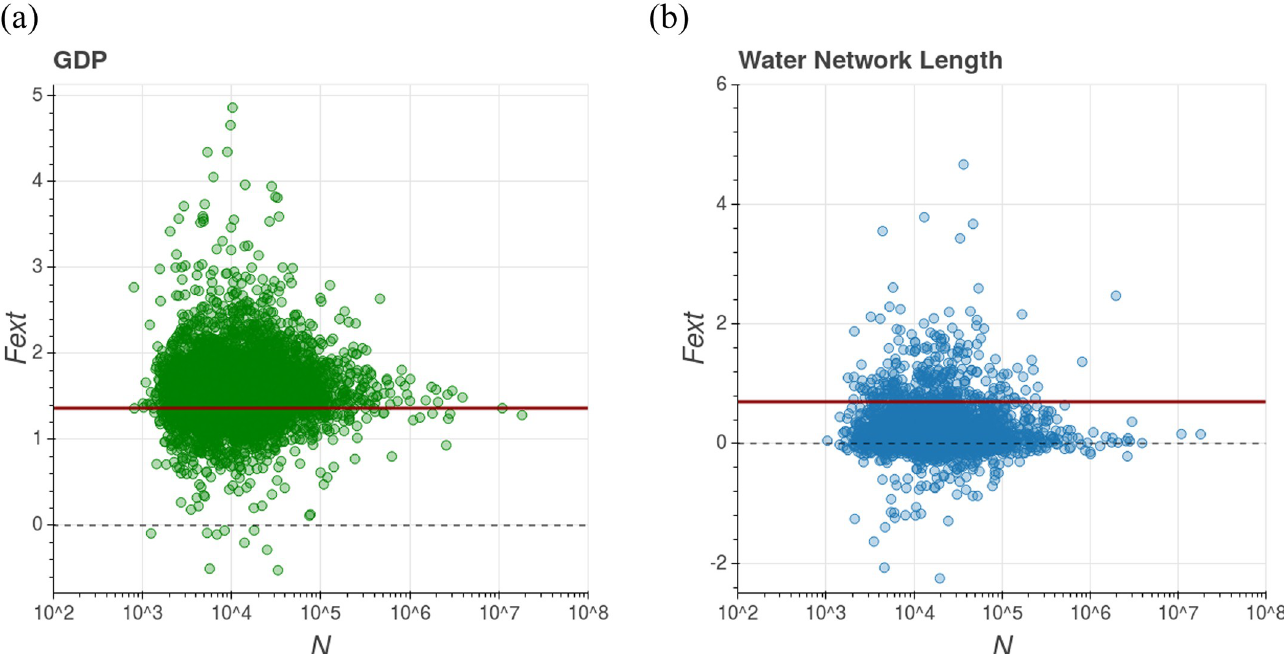
Fig 8. Magnitude of the external vector as a function of city population size. On the left, we have data referring to GDP and on the right to water network length. The dots represent F i computed from the expression (11) while the red line represents the average magnitude of this vector over the system, computed by ext the expression (7). The dashed line is F ext = 0. In the case of GDP, the municipality subsets of all sizes are distributed around the average value, but in the case of the water network length, the greater subsets presented external vector smaller than the average. These particularities imply different dynamics of the transversal scaling exponent, as shown in Fig 9.